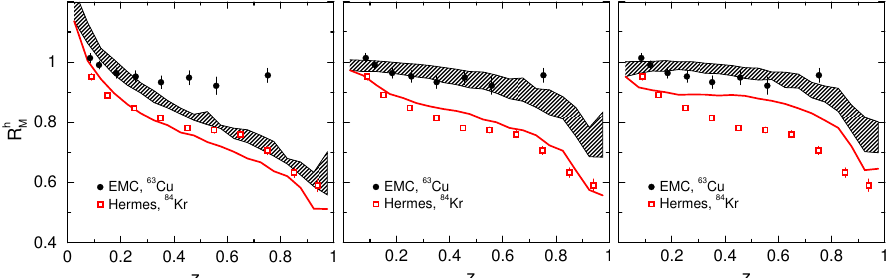
Figure 2. Nuclear modification factors, R h , for charged hadrons as a function of relative hadron M energy, z h = E h / ν , calculated by GiBUU, are compared with data from the experiments HERMES at 27 GeV beam energy [20] and EMC at 100 and 280 GeV [21]. The calculations are obtained with: the constant prehadronic cross section ( left ), linear ( middle ), and quadratic ( right ) time dependences. The shaded band shows the theoretical prediction for 100 and 280 GeV beam energies. See text for details. Taken from